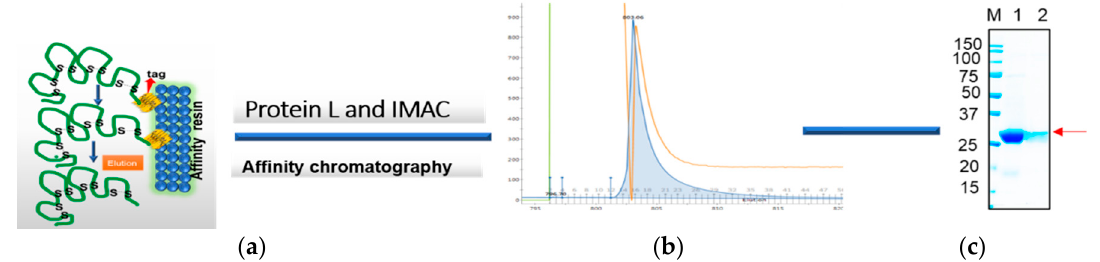
Figure 6. The affinity chromatography purification of the scFv fragment using protein L resin. The soluble antibody fragment was isolated from isopropyl β -d-1-thiogalactopyranoside (IPTG) induced bacterial cell pellet and subjected to affinity chromatography using an immobilized metal affinity matrix (IMAC) or a protein L column (binds to the kappa light chain of the antibody); ( a ) represents a schematic illustration of the chromatography. ( b ) A representative chromatogram peak image. ( c ) Eluted fractions were analyzed by 4–20% gradient SDS-PAGE under reducing conditions. Lane MW: molecular weight; lane 1: purified human scFv from periplasmic proteins; and lane 2: purified human scFv from cytosolic proteins.